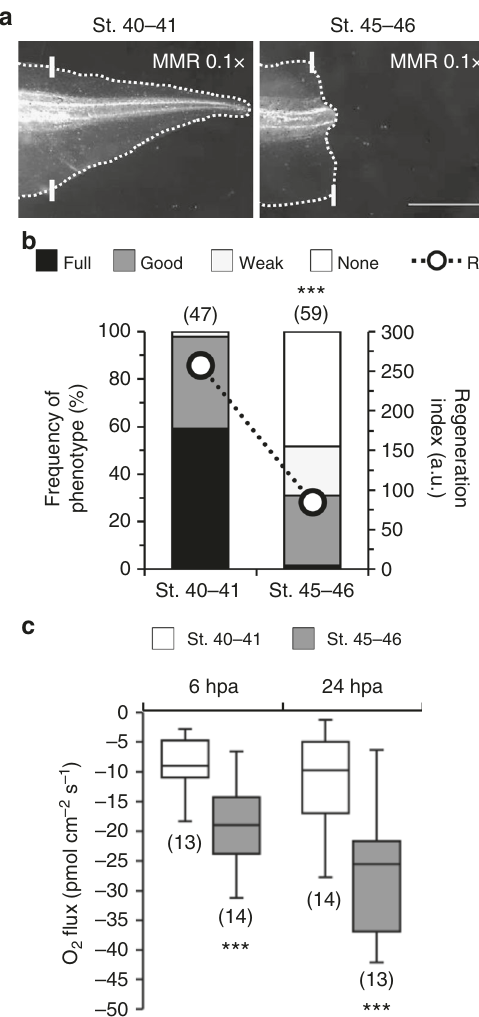
Fig. 2 Extracellular O 2 in fl ux predicts regeneration ef fi ciency. a Representative tails at 7 dpa in MMR 0.1× from tadpoles amputated in regenerative (st. 40 – 41) or refractory period (st. 45 – 46). White solid lines: amputation plane; scale bar: 1 mm. b Qualitative and quantitative